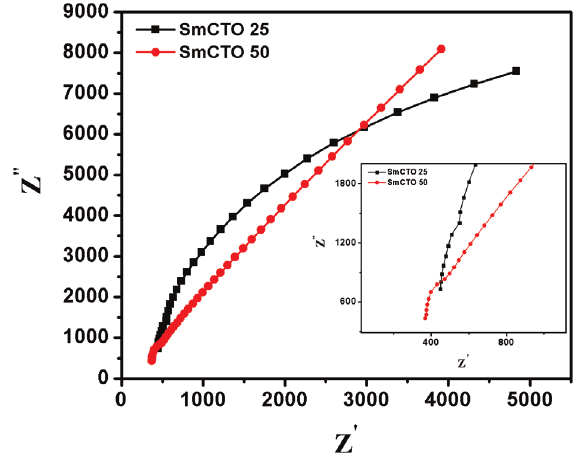
Sr NiO – 1.5 0.5 4